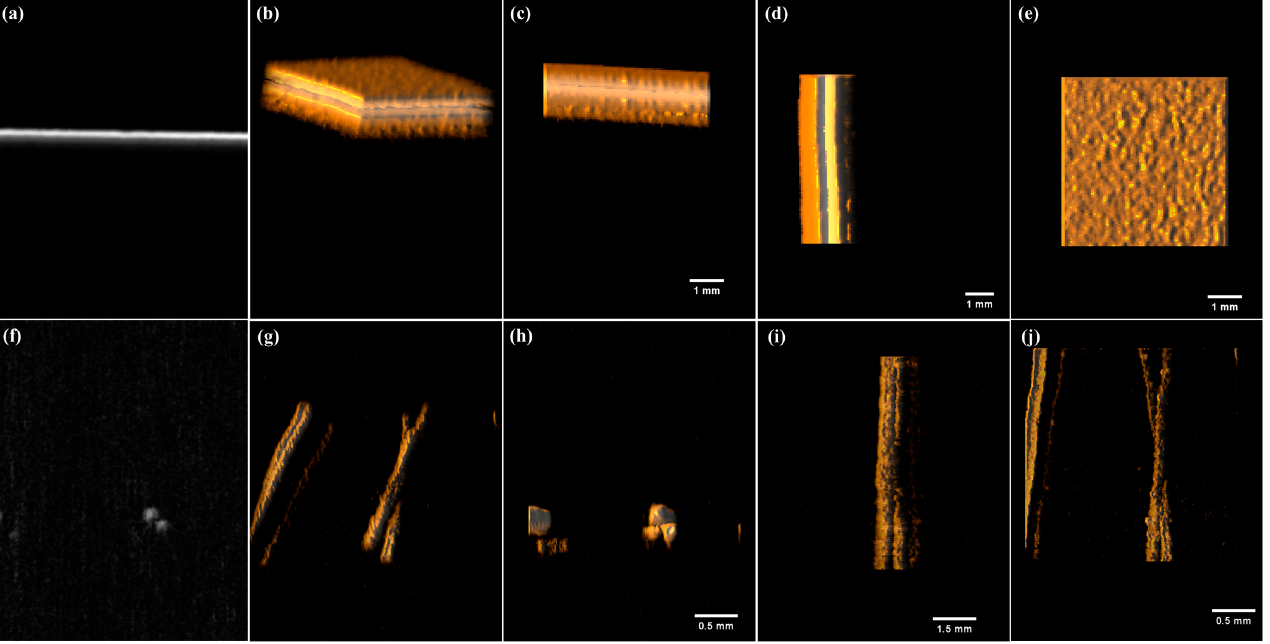
Figure 8. Experimental results for the PA imaging system obtained using insulating tape and hair: ( a ) original imaging result for insulating tape; ( b ) 3D reconstruction result for insulating tape; ( c ) insulating tape imaging result view of x- and y-axes; ( d ) result view of y- and z-axes; ( e ) result view of x- and z-axes; ( f ) original imaging result for the hair; ( g ) 3D reconstruction result for the hair; ( h ) hair imaging result view of x- and y-axes; ( i ) result view of y- and z-axes; ( j ) result view of x- and z- axes.